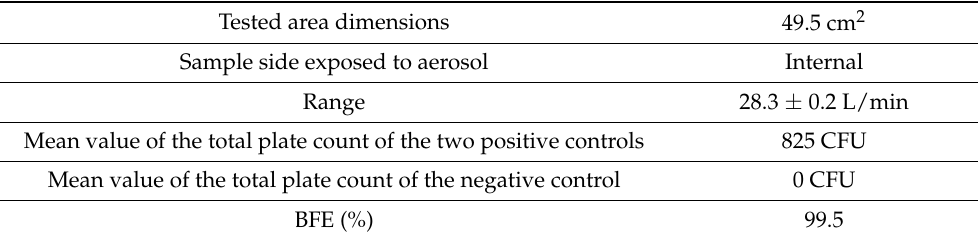
Table 4. Individual BFE values of FFP2 C. All samples exceeded the breathability and bacterial filtration tests (BFE). A BFE value greater than or equal to 98% was found on all samples, as required by the UNI EN 14683: 2019 + AC: 2019